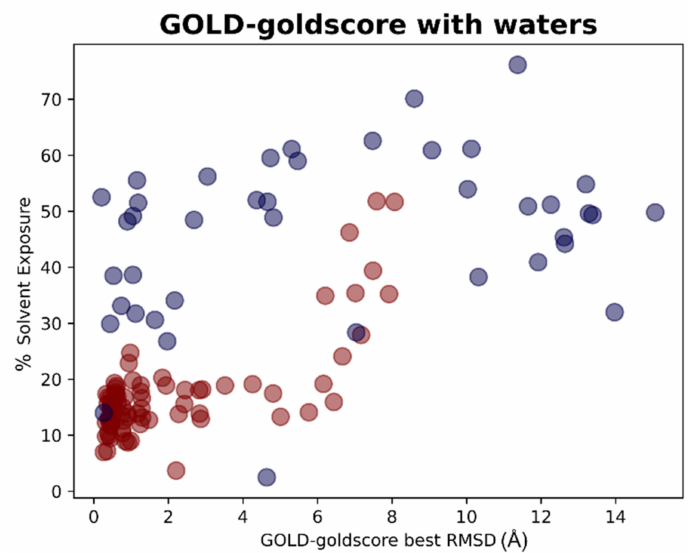
Figure 9. Scatter plots showing the different distribution of the RMSD values between the coordinates of the best pose from the GOLD-goldscore docking experiment in respect to the solvent exposure of the corresponding crystallographic ligands. The red dots represent the values having the ligand crystallized inside the catalytic pocket while the blue dots represent the ligands crystallized on the other sites of M pro . As can be noticed, the molecules showing the best values of RMSD are, in most cases, located inside the orthosteric pocket and characterized by low solvent exposure. This plot depicts part of the results of Scenario 1, and so the crystallographic water molecules are not considered in the docking runs of which the outcomes are here represented.